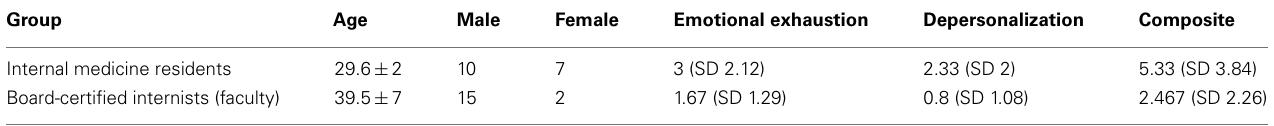
Table 1 | Group demographics and Maslach Burnout Inventory